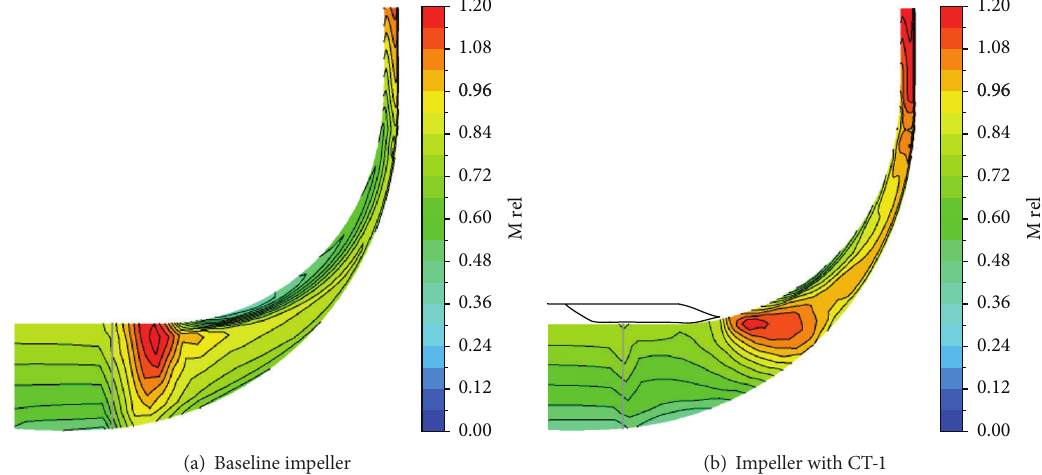
Figure 25: Circumferentially mass averaged relative Mach number distribution in meridional plane at respective choke flow rates of baseline and CT-1 impellers.